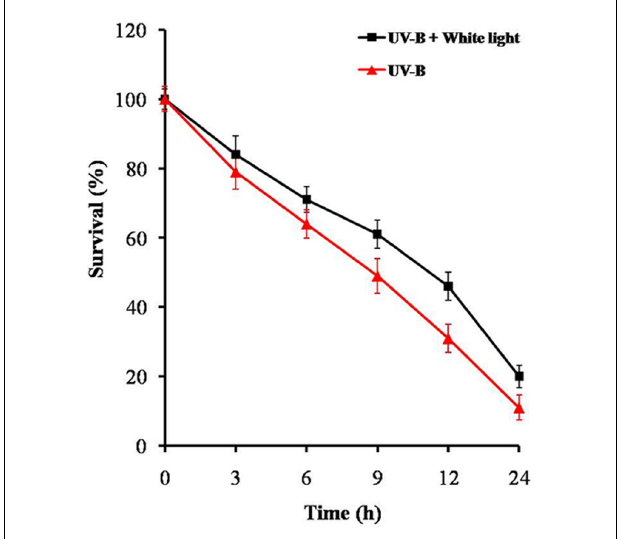
FIGURE 1 | Percent survival of Anabaena L31. An exponentially grown culture was exposed to UV-B (1W m − 2 ) + white light or UV-B (1W m − 2 ) alone for desired time period and thereafter survival was determined. Results are based on the average of three experiments performed independently under identical